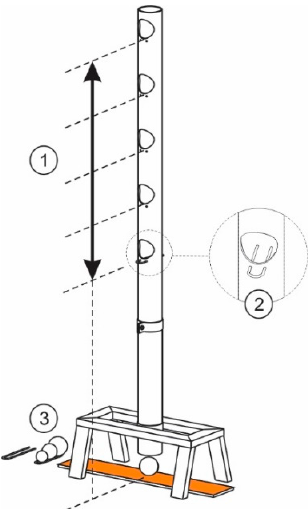
Figure 2. Device for testing dynamic hardness: 1. drop height; 2. drop support; 3. ball diameters.